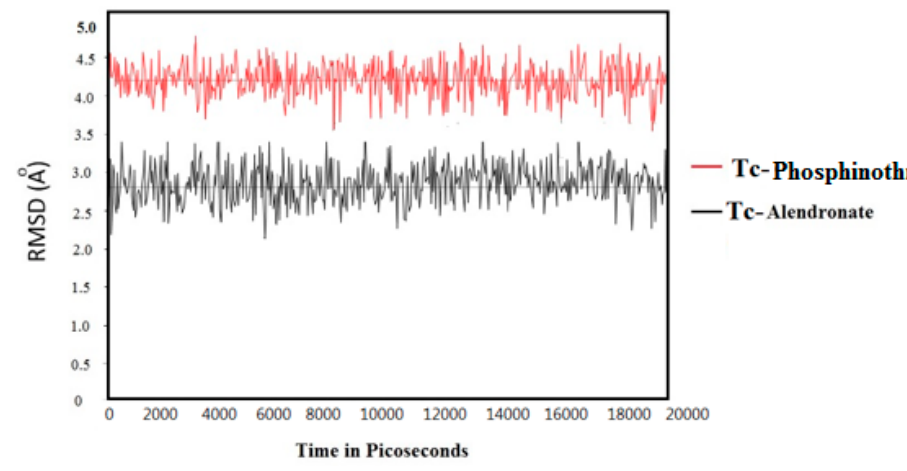
Figure 7. The computed RMSD ( Ǻ ) of 99m TC complex of both phosphinothricin and alendronate.